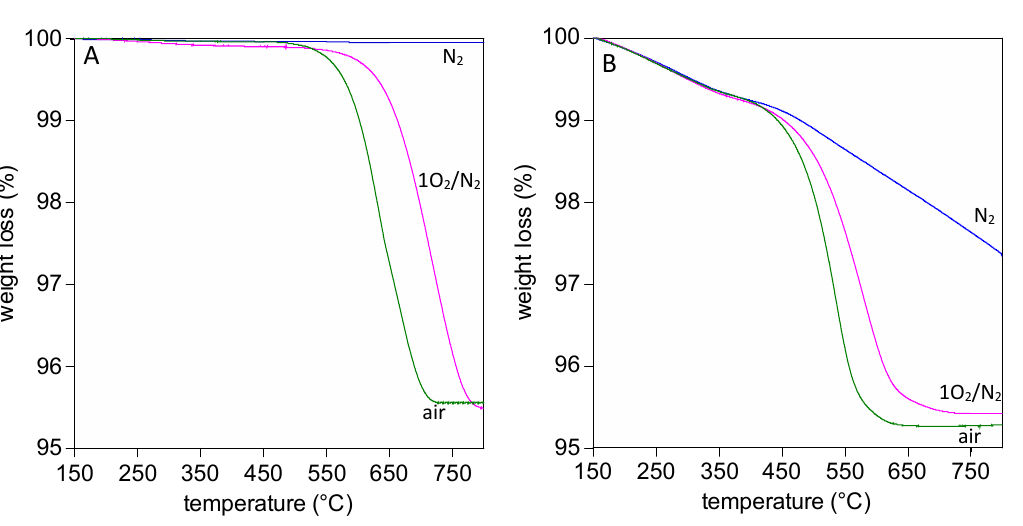
Scheme 2. Mechanism of reaction for oxygen transfer over soot / CZ mixtures.